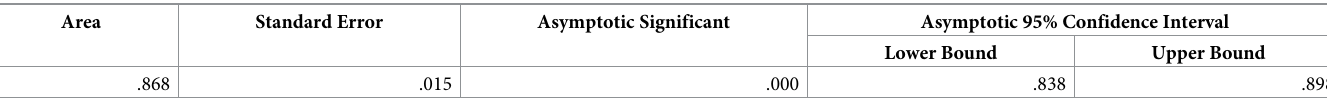
Table 4. Area under the curve based on data from April 10,